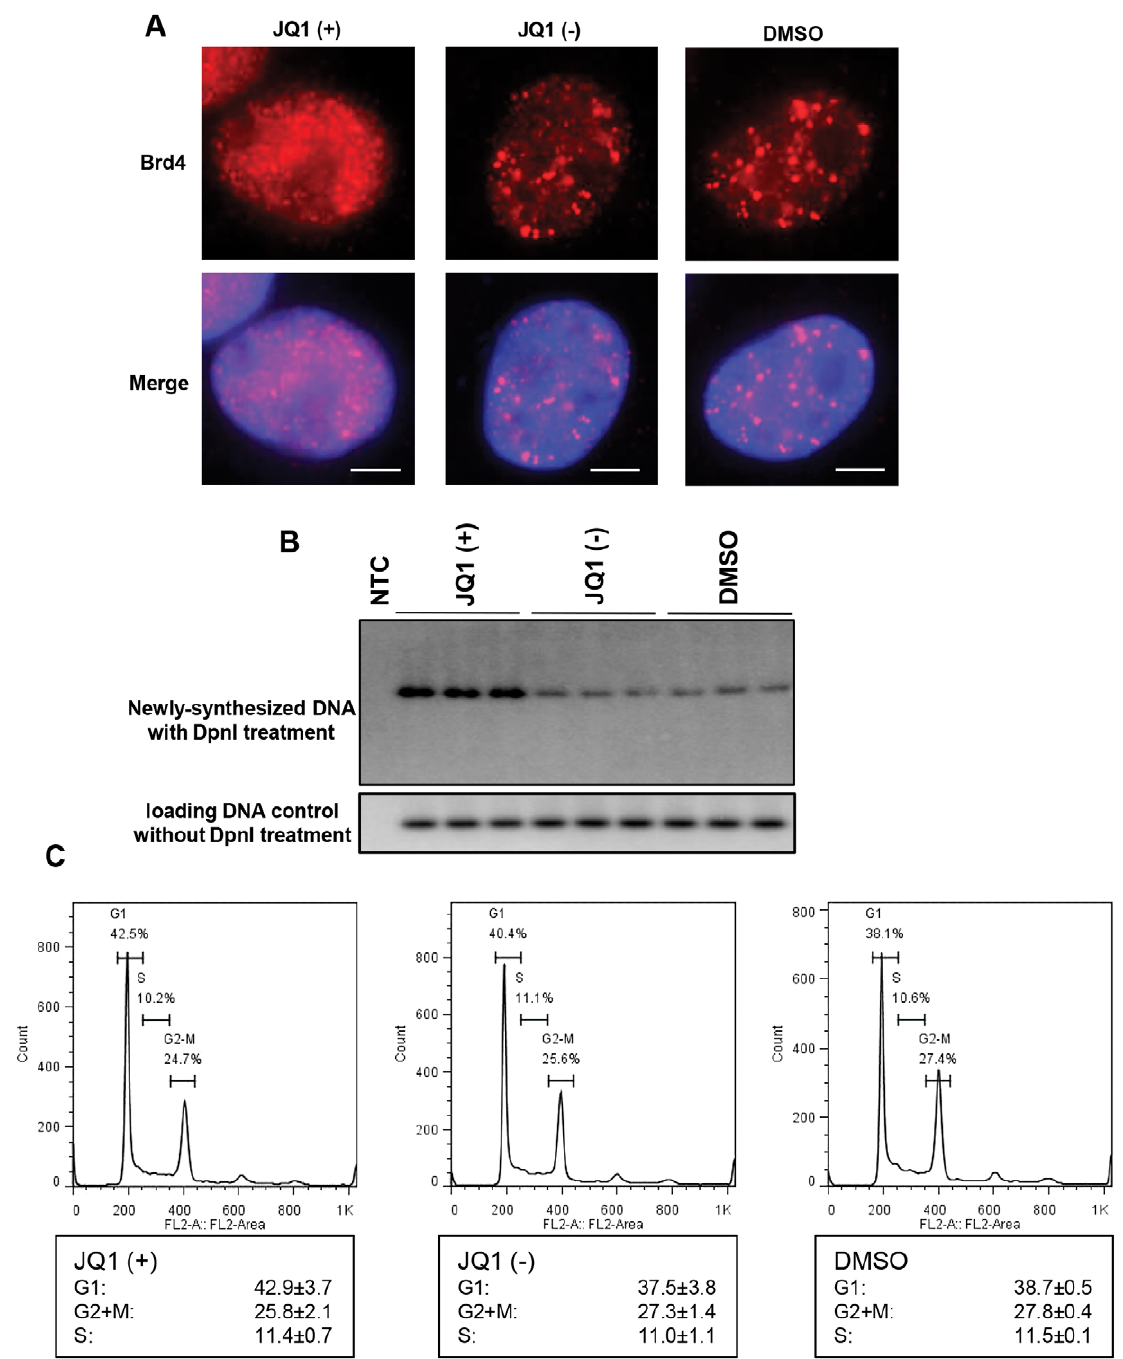
Figure 6. JQ1( + ) treatment increases the MCV replication. A . JQ1( + ) releases Brd4 from chromatin. C33A cells were treated with 300 nM JQ1( + ), JQ1( 2 ) or DMSO for 24 h. Cells were fixed and stained with Brd4 antibody and DAPI. B . JQ1( + ) treatment increases the MCV replication. C33A cells were transfected with pT + Ori and split into 3 dishes. At 24 h p.t., cells were treated with 300 nM JQ1( + ), JQ1( 2 ) or DMSO. Total DNA was extracted at 48 h p.t., and 20 m g of XhoI/DpnI-digested DNA was loaded in each lane for Southern blotting to detect the replicated plasmid. 1.5 m g total DNA samples that have been digested with XhoI but not with DpnI were also analyzed in Southern-blotting to show equal loading of DNA. NTC, no transfection control. All reactions were performed in triplicates. C . JQ1( + ) treatment does not affect cell cycle. C33A cells were cultured for 12 h and treated with 300 nM JQ1( + ), JQ1( 2 ) or DMSO. Cells were cultured for another 24 h and fixed for FACS cell cycle analysis. DNA replication components to the active replication forks. In helicases, such as the SV40 LT and the papillomavirus E1 protein, form double hexamers at the viral origin to induce origin melting host DNA replication, the minichromosome maintenance and processive DNA unwinding, while recruiting other cellular (MCM2-7) complex functions as the eukaryotic replicative helicase